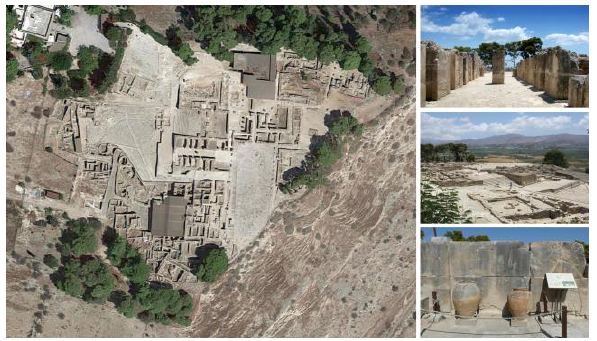
Figure 1. The Palace of Phaistos ( D. Aiello